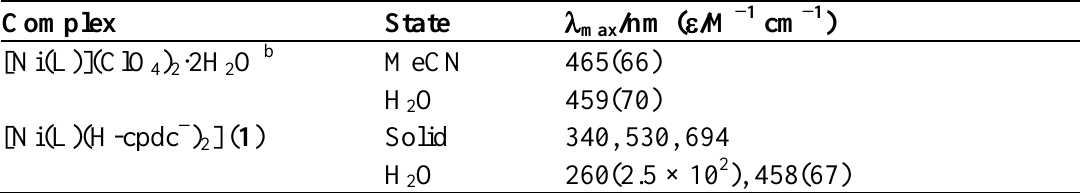
Table 3. Electronic spectral data a .